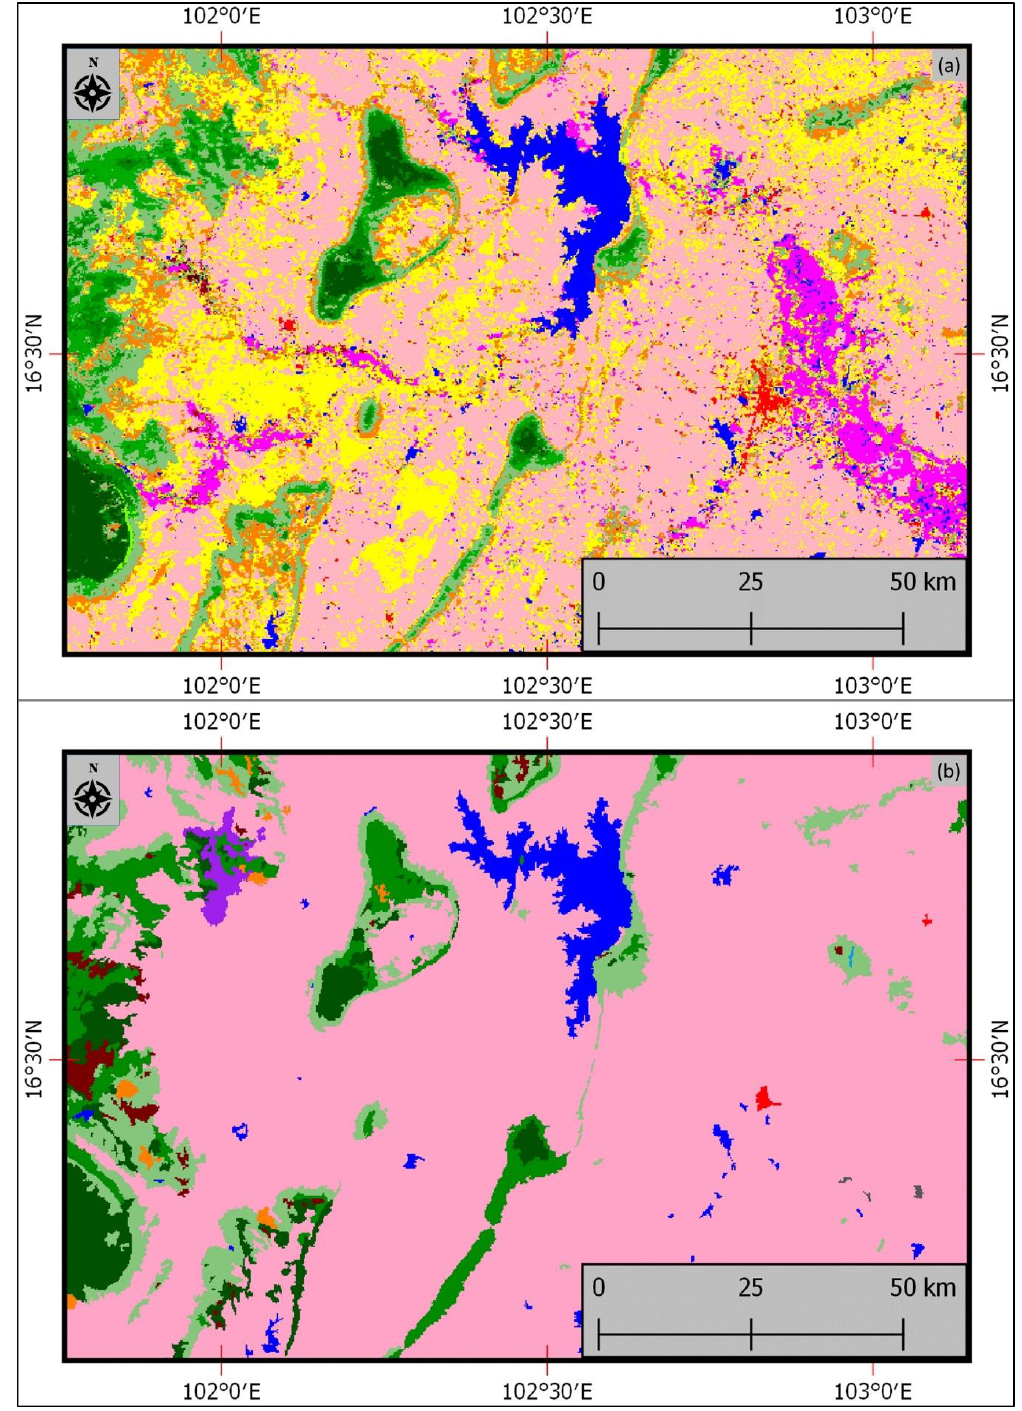
Figure 9. Enlarged subset of study area, comparing the ( a ) 2010 LULC map from the project to ( b ) recoded 1997 LULC map from MRC. The legend for the 2010 LULC map is given in Figure 7 and the legend for the 1997 LULC map is shown in Figure 8.